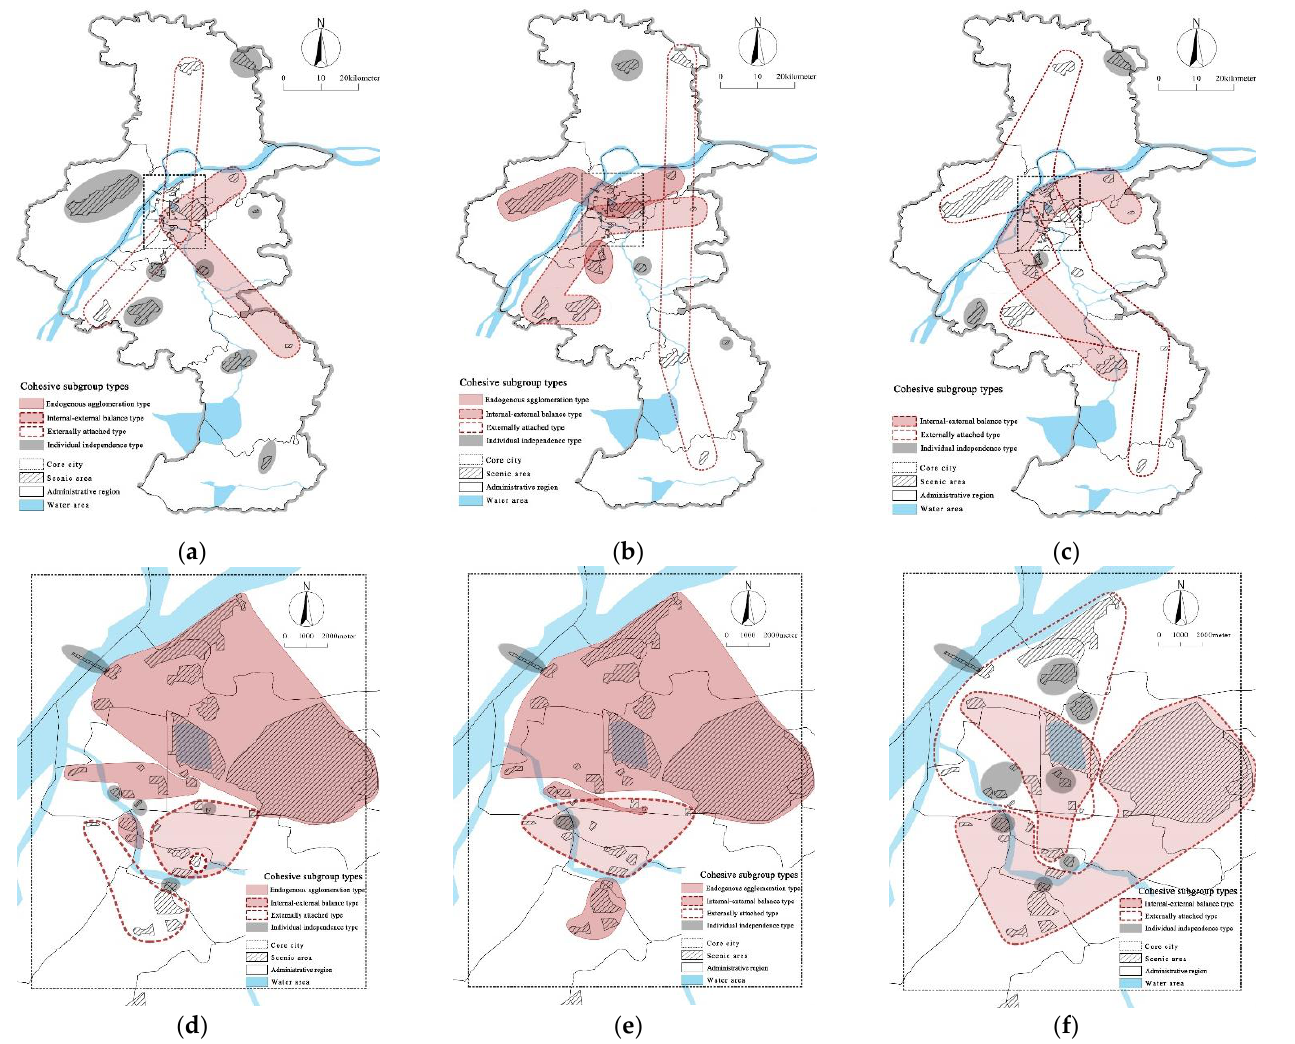
Figure 11. Cohesive subgroups’ spatial distribution of tourism flow networks under three types of network context (overall, resident, and non-local tourist): ( a ) overall cohesive subgroup of entire city; ( b ) resident cohesive subgroup of entire city; ( c ) non-local cohesive subgroup of entire city; ( d ) overall cohesive subgroup of core city; ( e ) resident cohesive subgroup of core city; ( f ) non-local cohesive subgroup of core city.